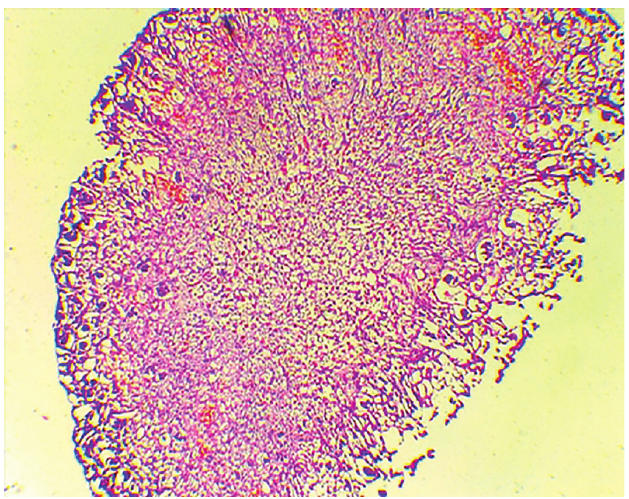
FIGURE 2(G) - Photomicrograph of section of skin of neonate of pregnant rat exposed to pesticide glyphoshate shows slight thinning of epidermis (TE) (H & E 100X).